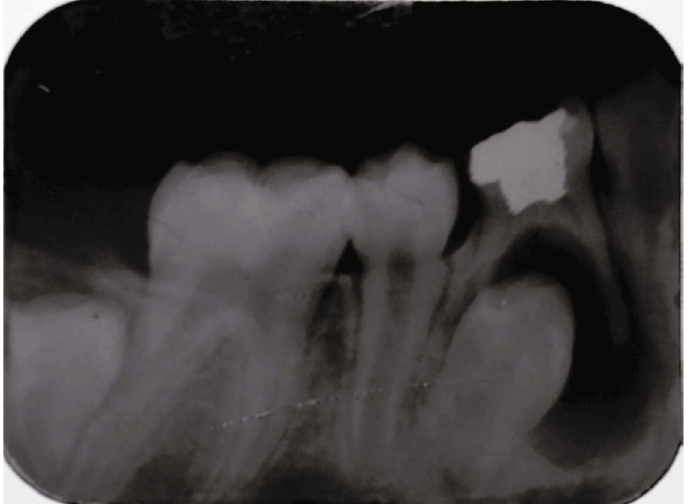
Figure 3: Retroalveolar radiograph showing radiolucency associated with an endodontically treated fi rst right primary molar (tooth 84).